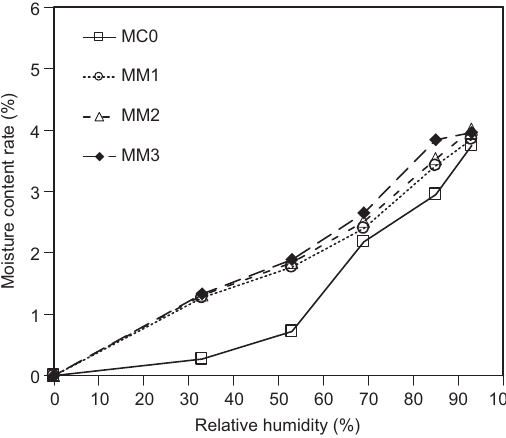
Figure 7 Adsorption isotherms of cement mortars within various RHs vs. the montmorillonite contents.